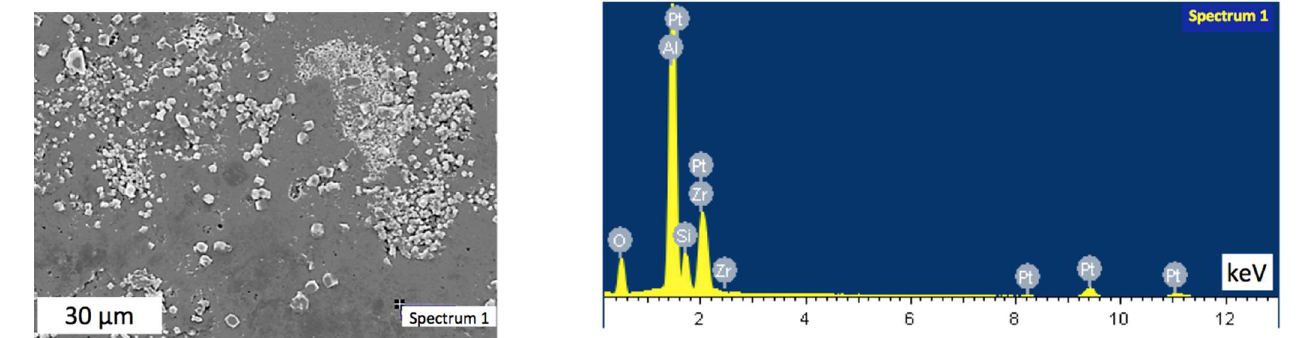
Figure 7. Elemental analysis in point 1 of the sample #4. Table 1. Elemental proportions in point 1 of the sample #4.